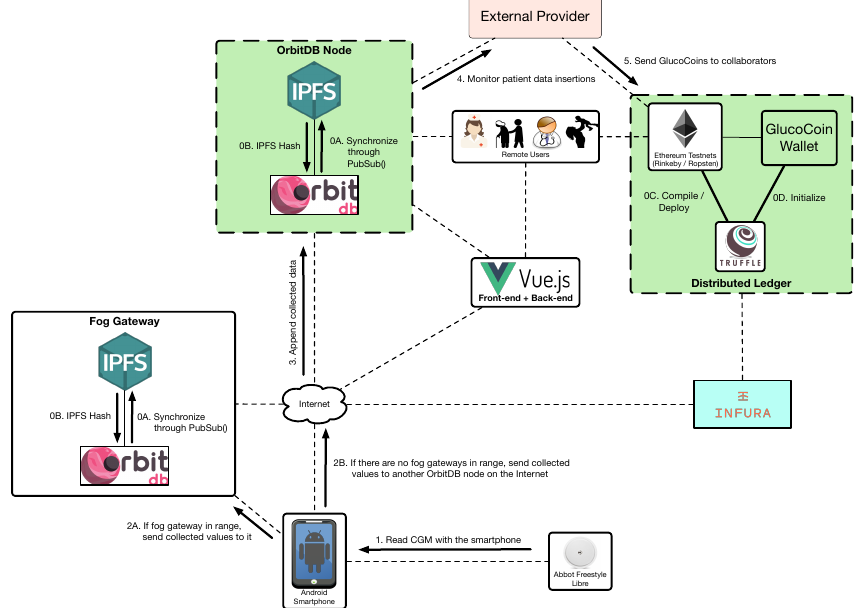
Figure 6. Insertion process for the data collected from the